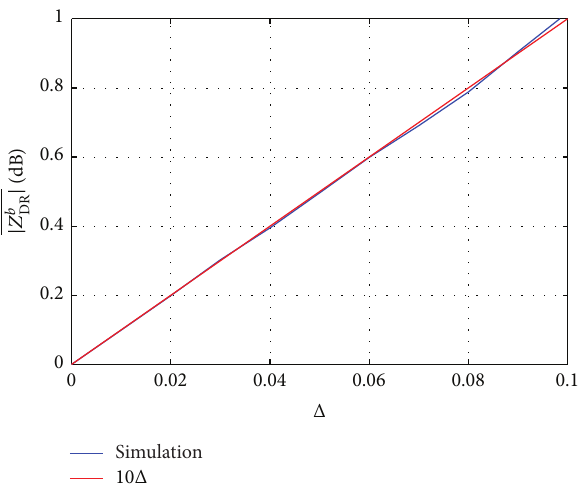
Figure 4: The relation between Δ and |𝑍 𝑏 DR |